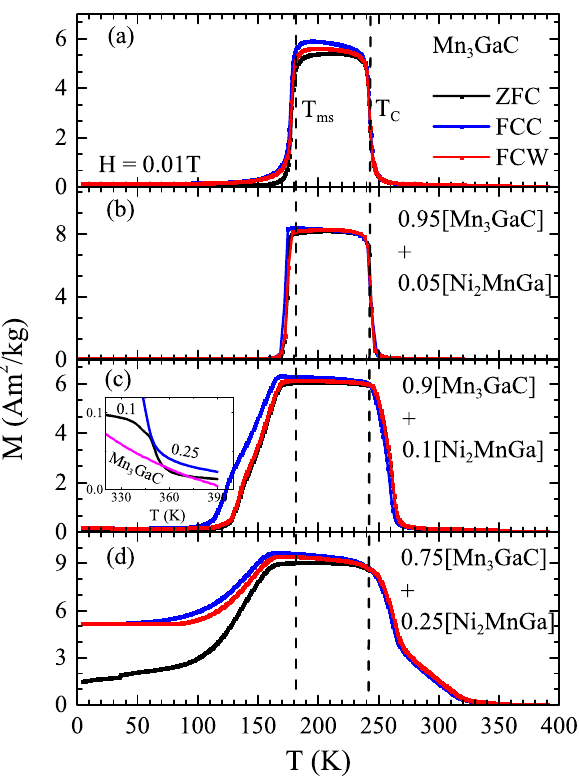
Figure 3. Magnetization as a function of temperature M(T) in Mn 3 GaC and composites of Mn 3 GaC and Ni 2 MnGa with y = 0.05, 0.1 and 0.25. The vertical lines indicate positions of T ms and T C in Mn 3 GaC. Inset shows expanded view of ZFC magnetization curves in Mn 3 GaC, y = 0.1 and 0.25 in the temperature range 325 K ≤ T ≤ 395